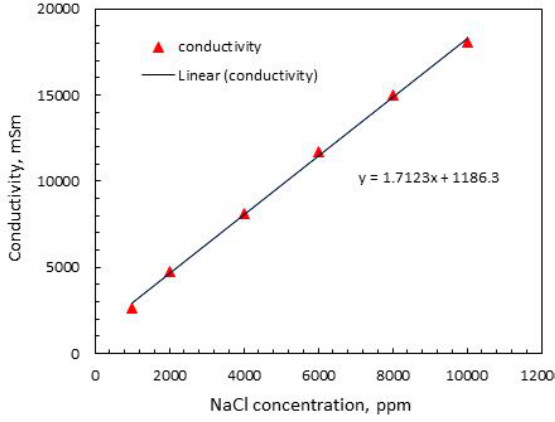
Fig. 2. Conductivity versus different standard NaCl